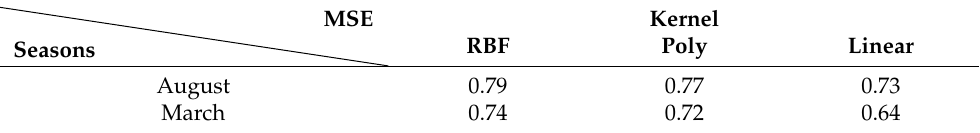
Table 4. Selection of kernel function.